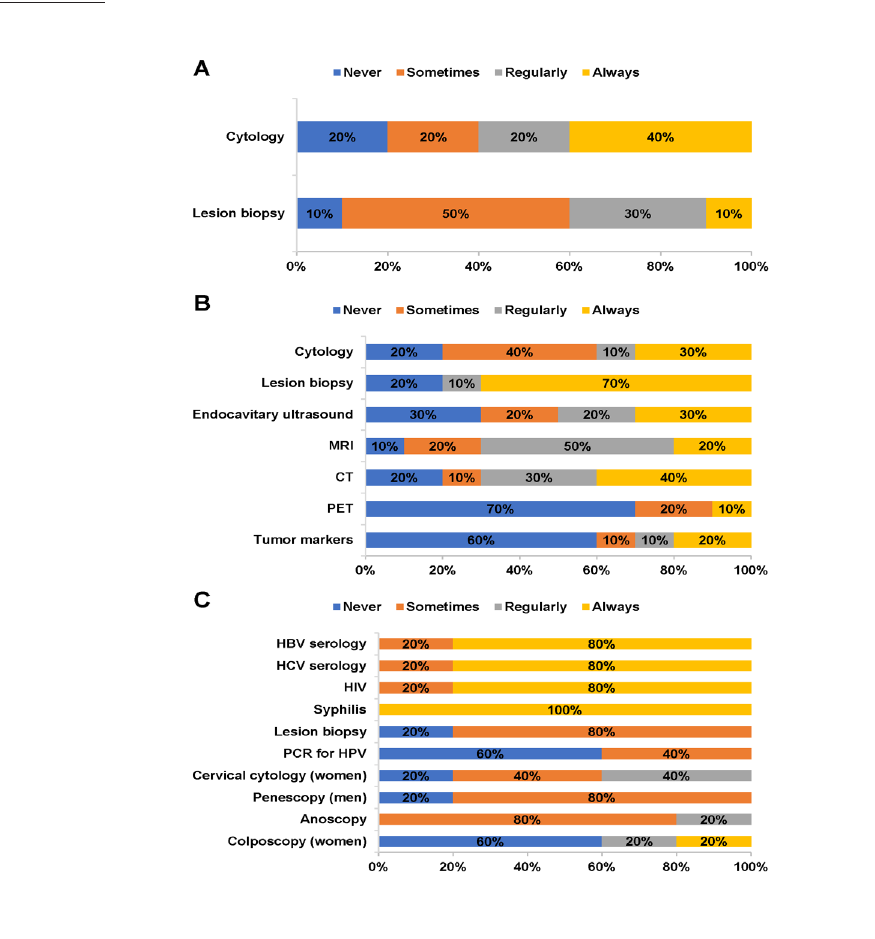
Figure 1. Diagnostic Tests for (A) CIN, (B) , Cervical Cancer, and (C) Genital Warts